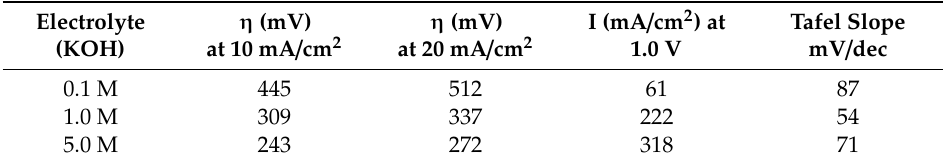
Table 3. Overpotential values calculated at 10 and 20 mA / cm 2 , and current density at 1.0 V vs. SCE, of Co 3 O 4 (3) / lsm -TiO 2 obtained in various KOH concentrations.